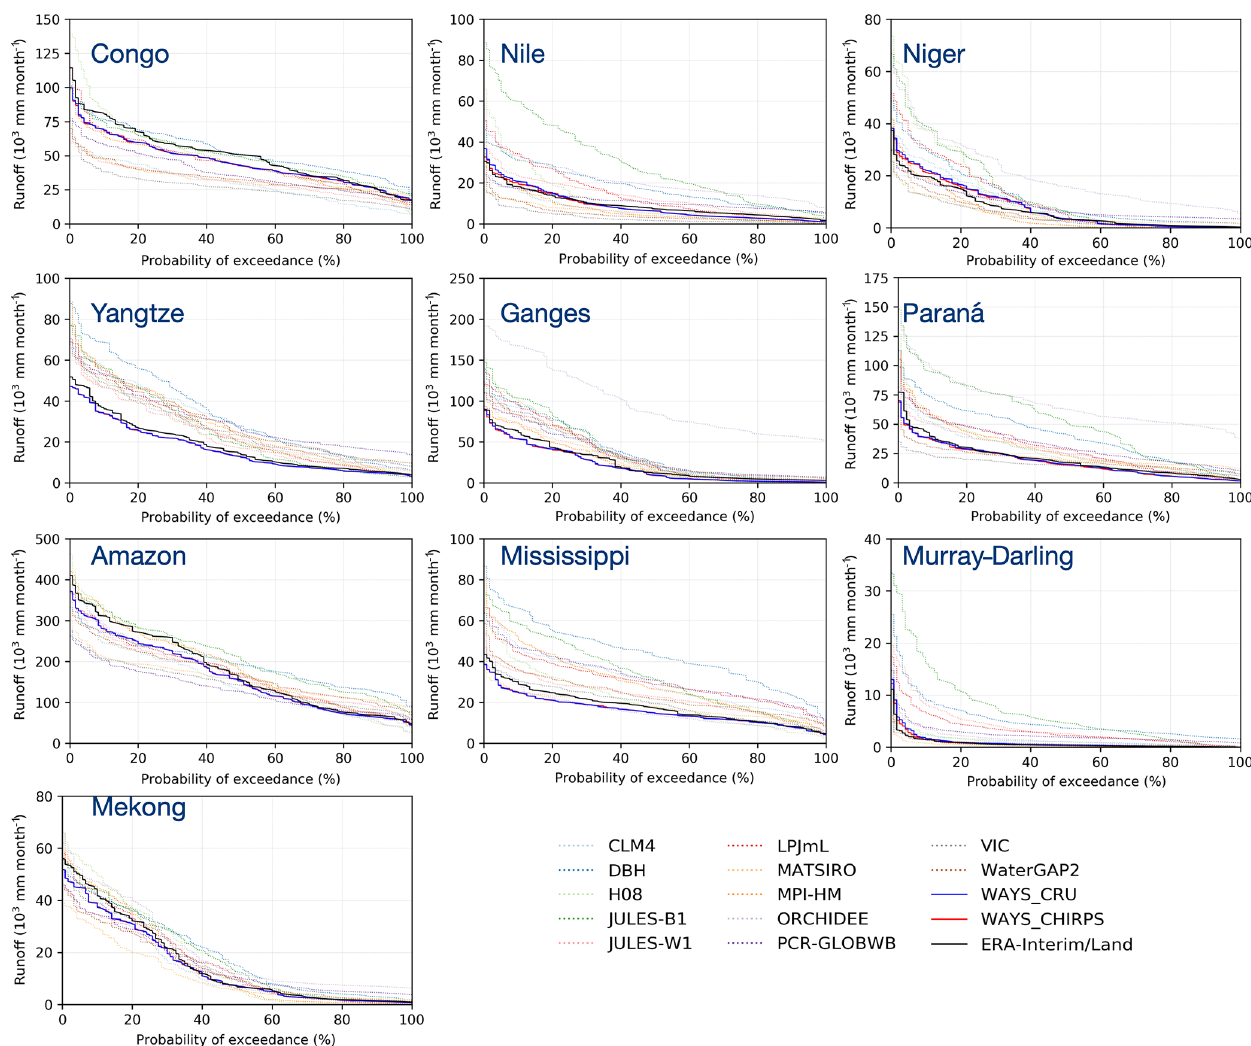
Figure 3. The probability of exceedance for monthly runoff simulated by different models as well as the reference data in 10 selected basins. The solid lines in blue and red indicate WAYS simulations with two different RZSC products. The solid line in black indicates the ERA- Interim/Land data, and dashed lines represent the ISIMIP2a model simulations. In some plots, the red line is not visible and is covered by the blue line due to the small differences between the two WAYS runs. WAYS is calibrated using composite monthly runoff data, while the ISIMIP2a models are not calibrated for the